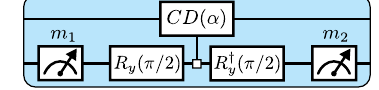
FIG. 9. Reward circuit for learning preparation of arbitrary symmetric states of a continuous-variable system, based on the characteristic